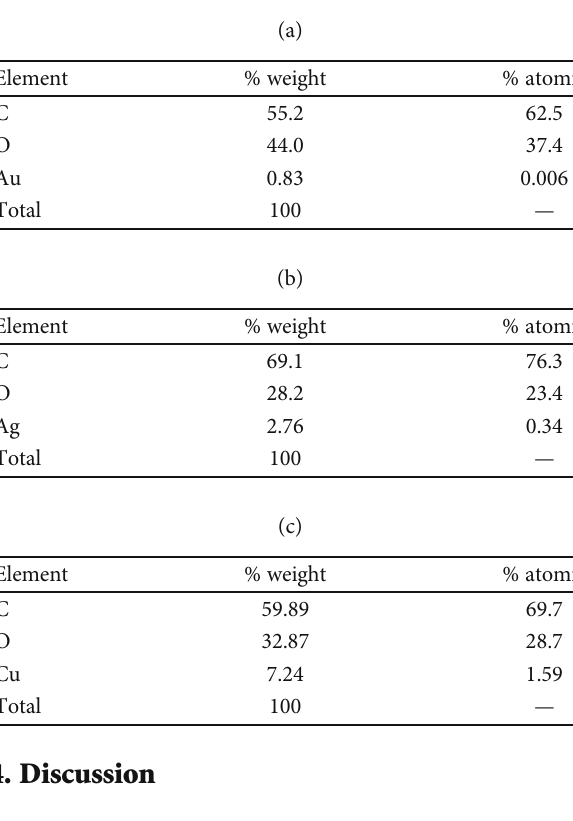
Table 3: Percentage of mass and atomic of elemental analysis by EDX of QDs of (a) gold, (b) silver, and (c) copper in the concentration of 0.1g/L.